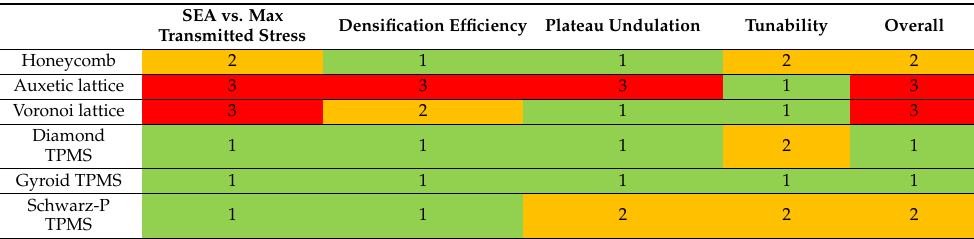
The color indicates performance level of the structure: green indicates good performance, yellow indicates average performance, and red indicates poor